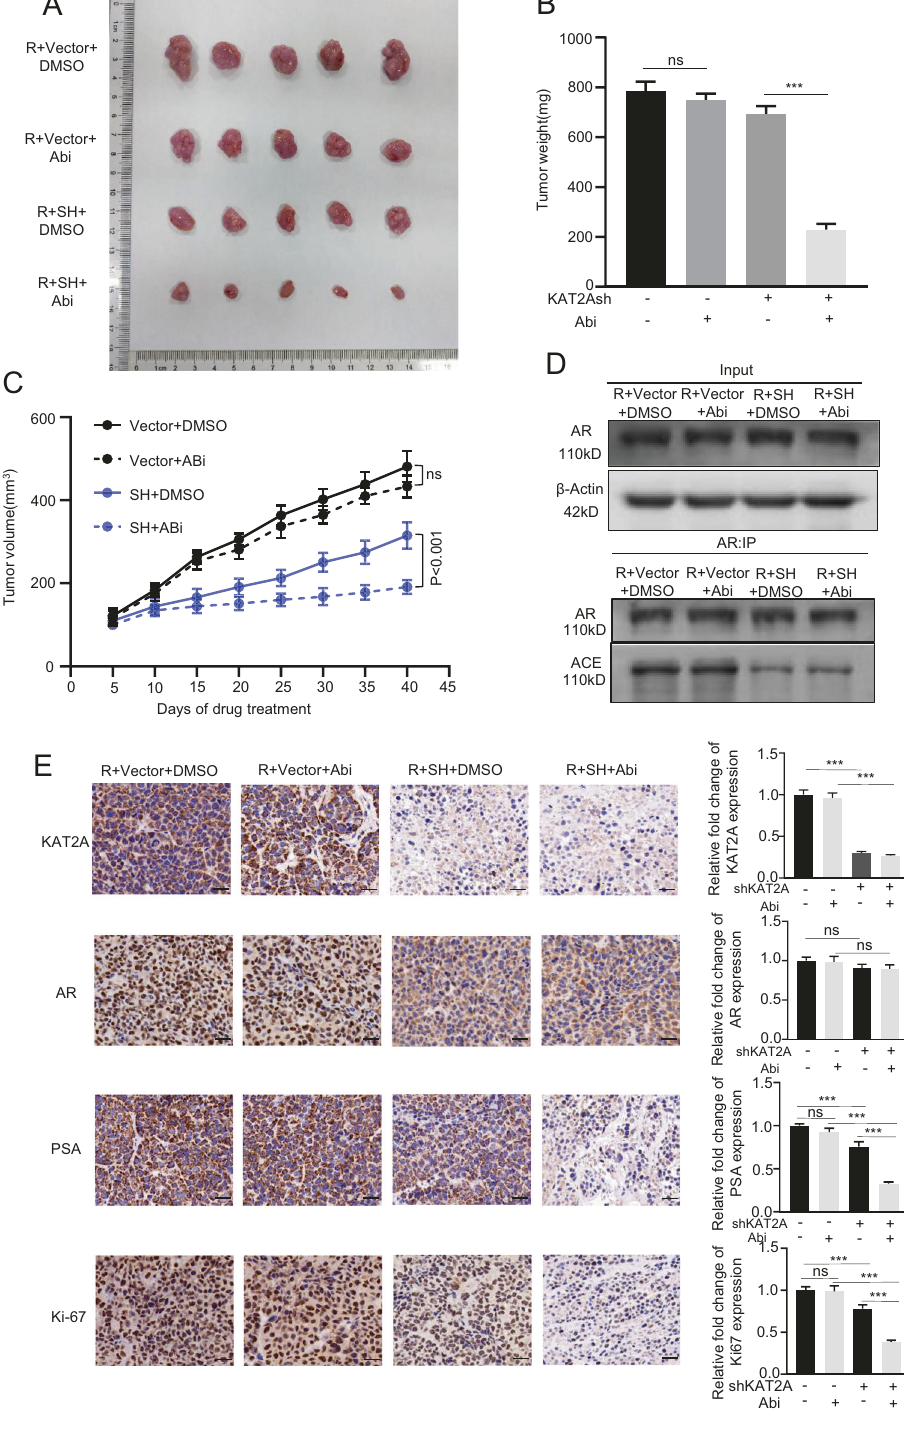
Fig. 6 Knockdown of KAT2A reduces abiraterone-resistant CRPC proliferation in vivo. A Nude mice bearing C4-2-AbiR with stable KAT2A knockdown xenografts were treated with vector control or abiraterone acetate and prednisolone for ~7 weeks ( n = 5). B Tumours were weighed after resection at the end of the experiment. C Tumour volumes were measured every 5 days. Data are shown as the means ± SD. D Acetylation of AR in xenograft tissue was detected by western blot. E IHC detection of the expression of KAT2A, AR, PSA and Ki-67 in each group was performed. * p < 0.05, ** p < 0.01, *** p <